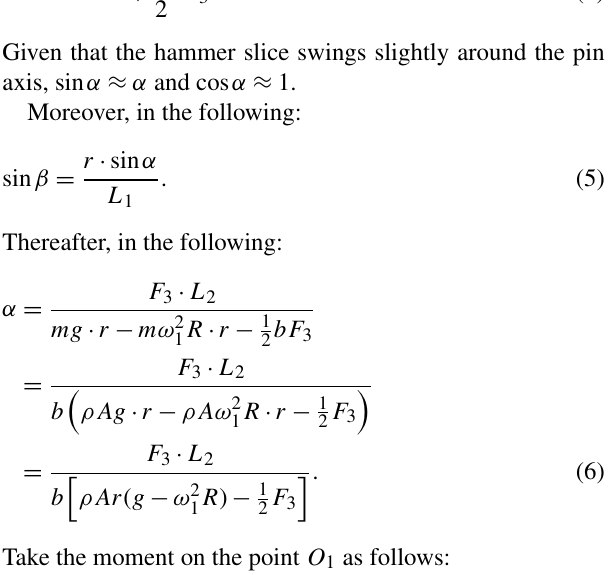
the spindle, F 2 is the centrifugal force generated by the ro- tation of the hammer slice around the pin, f is friction be- tween the hammer slice and inner surface of the pin hole, N is the pressure between the hammer slice and the inner sur- face of the pin hole, and mg is the gravity. Forces subjected to the hammer sheet include gravity (mg) acting on the cen- troid, centrifugal force F 1 , F 2 , motion resistance F 3 during motion, and force N , f , which act on the hinge of the ham- mer slice and pin. The motion consists of the rotation of the hammer slice around the axis of the spindle ω 1 and the sim- ple pendulum motion of the hammer slice around the axis of pin ω 2 . When the hammer mill works, the hammer slice moves with the spindle at high speed under the connection of the pin. Moreover, there is a deflection angle β when the hammer slice moves, and the positive pressure between the hammer slice and pin is produced during movement. Thus, friction force is produced on the contact